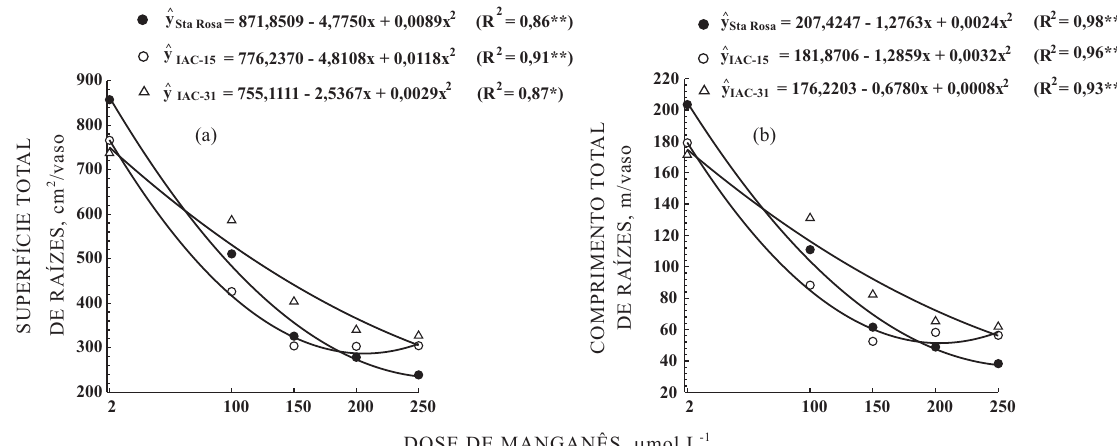
Figura 3. Superfície total (a) e comprimento total de raízes (b) dos cultivares Santa Rosa ( ), IAC-15 ( ) e IAC-Foscarin 31 ( ΔΔΔΔΔ ), considerando as doses de 2, 100, 150, 200 e 250 μ mol L -1 de Mn, em solução nutritiva.